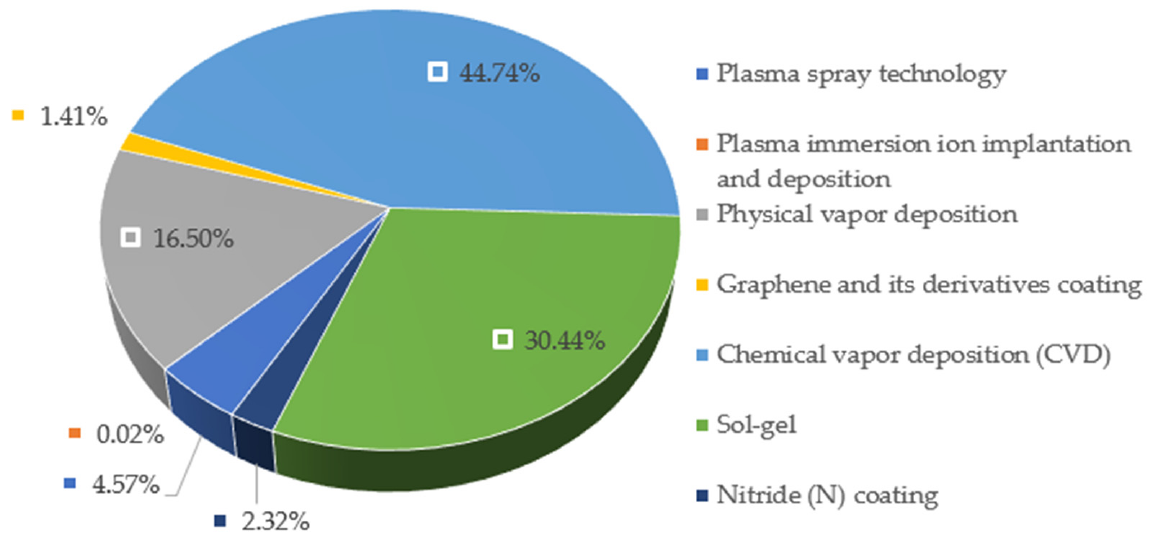
Figure 8. Research conducted in different areas of coating technologies since 2014, in Google Scholar database.